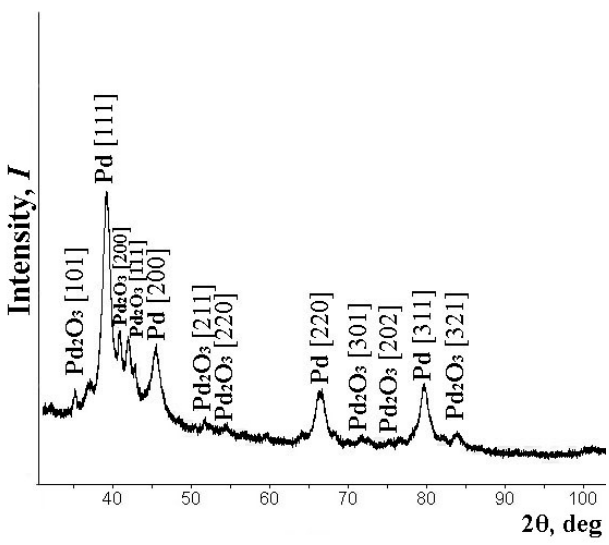
Figure 1. Typical X-ray diffraction samples of the nanocomposite.